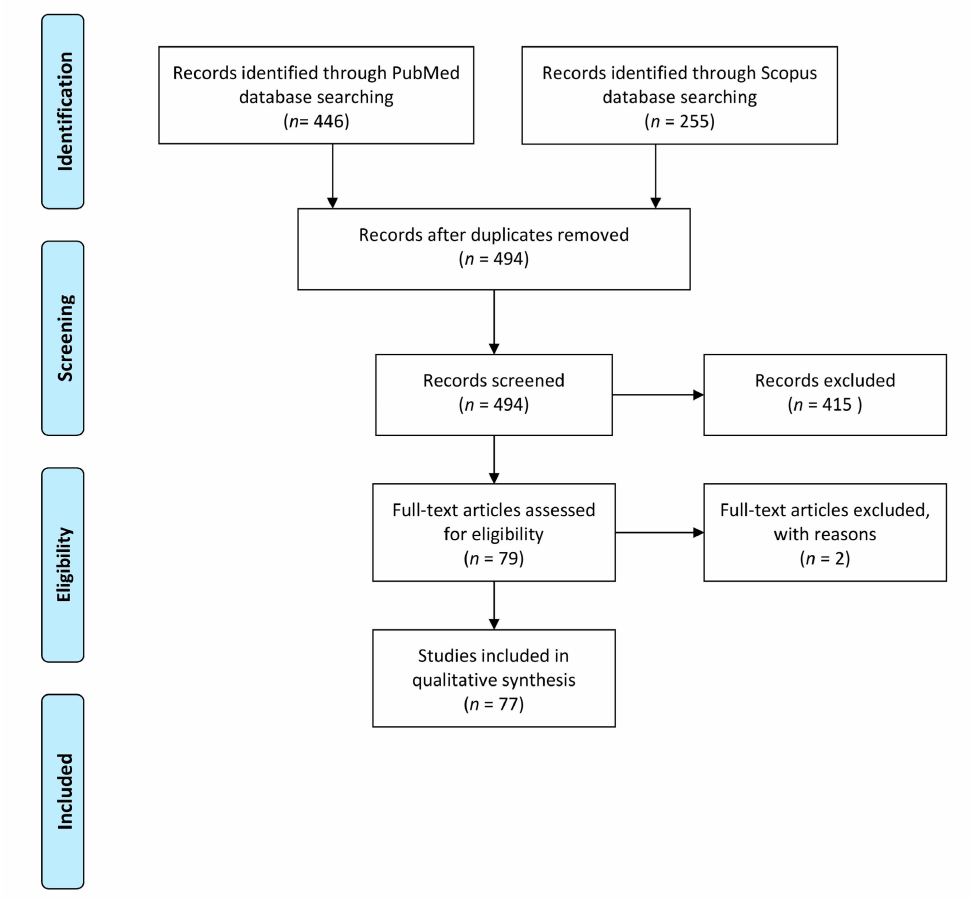
Figure 1. PRISMA flow diagram of the search strategy steps for the literature